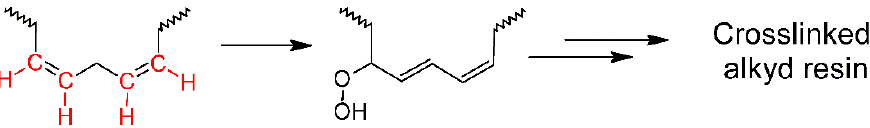
Figure 4. Simplified mechanism of the autoxidation process with highlighted cis -C= C – H groups monitored by infrared spectroscopy.